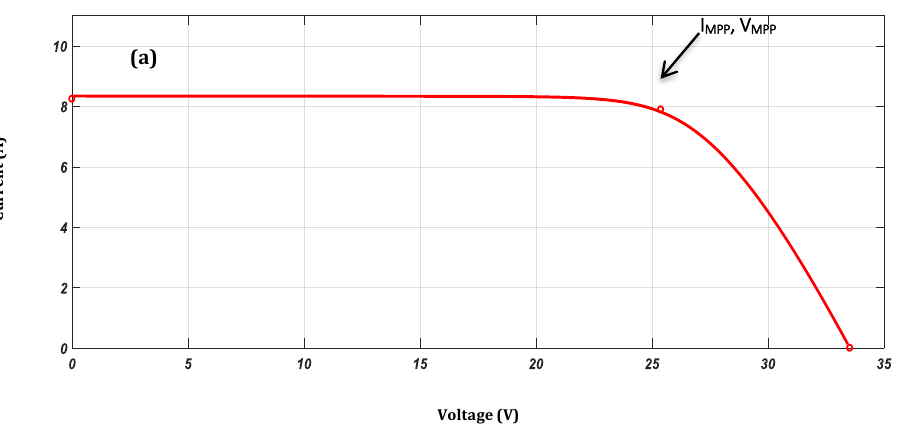
Figure 6. Characteristic curves of the PV module: ( a ) Current-voltage I-V curve, ( b ) Power-voltage curve P-V. Influence of temperature and Irradiance on I-V and P-V characteristics: The temperature is a very important parameter in the operation of a PV module because of the temperature sensitivity of the electrical properties of the semiconductor. The characteristic I-V and P-V of a PV module according to the temperature under con- stant solar radiation (1000 W/m 2 ) is represented in Figure 7a,b. We note that this charac- teristic I-V varies only slightly when the temperature varies, which means that the tem- perature has an effect over a long period of operation. It shows that the short-circuit current (I.S.C.) increases slightly with the temperature. It is thus observed that the in- fluence of the temperature on (I.S.C.) and the maximum power current can be negligible